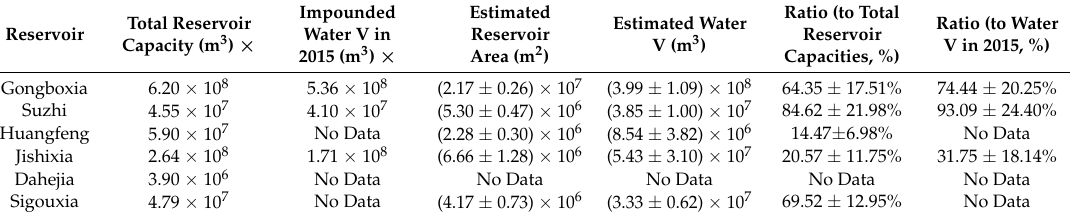
Table 1. Total reservoir capacity, water storage volume (V) at the end of 2015, estimated inundation areas, estimated water storage V, and ratios of estimated water V to the total reservoir capacity and the water V in